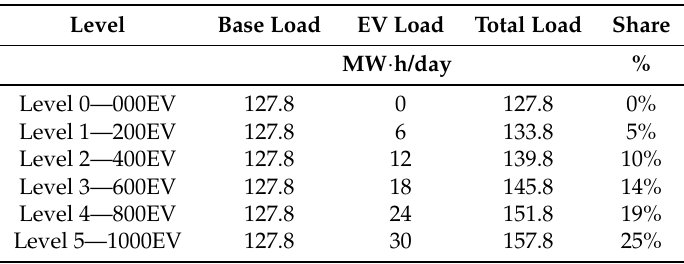
Table 2. Base load, EV load, total load, and share at each